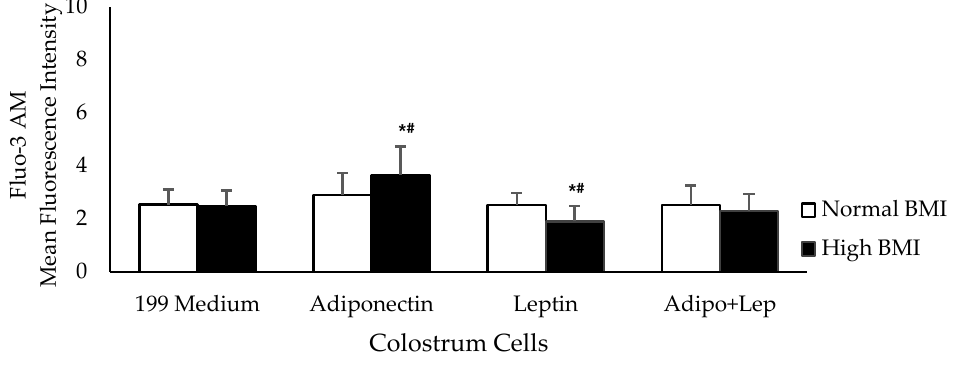
Figure 3. The effects of adiponectin and leptin on the release of intracellular calcium by colostrum mononuclear phagocytes from women with normal BMI and high BMI values incubated with Zymosan A from Saccharomyces cerevisiae . Intracellular calcium release was performed with Fluo-3AM (n = 10). The results are presented as the mean ± SD (n = 10 per group). They were assessed by ANOVA and Tukey’s Test. * Statistical di ff erence between colostrum cells incubated with 119 medium and hormones within groups ( p < 0.05). # Statistical di ff erence among groups with the same treatment and sample ( p < 0.05).